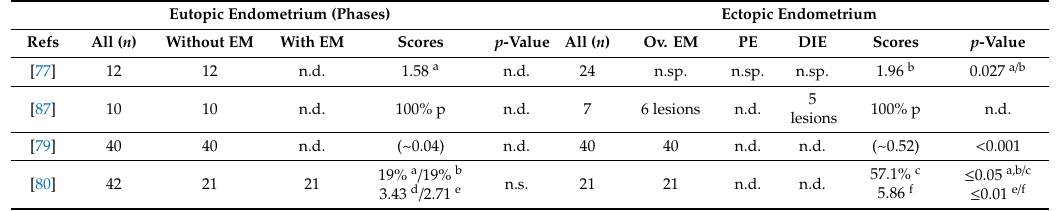
Table 4. Immunohistochemistry of Snail in eutopic and ectopic endometrium. Eutopic Endometrium